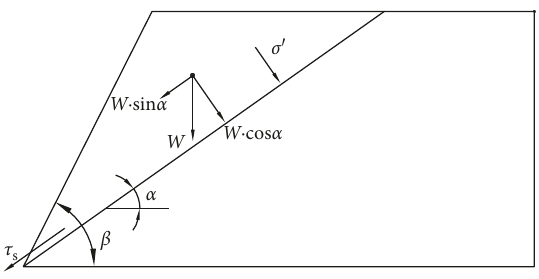
Figure 1: Force states of the sliding body in LE